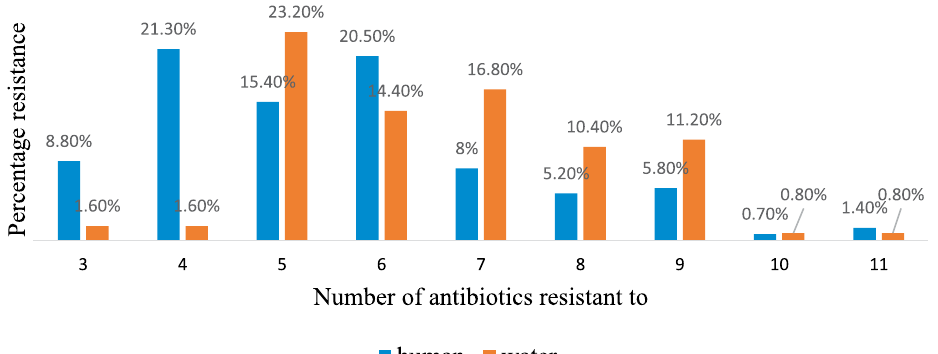
Fig. 2. percentage of MAR E. coli isolates from human and water samples resistant to a different number of